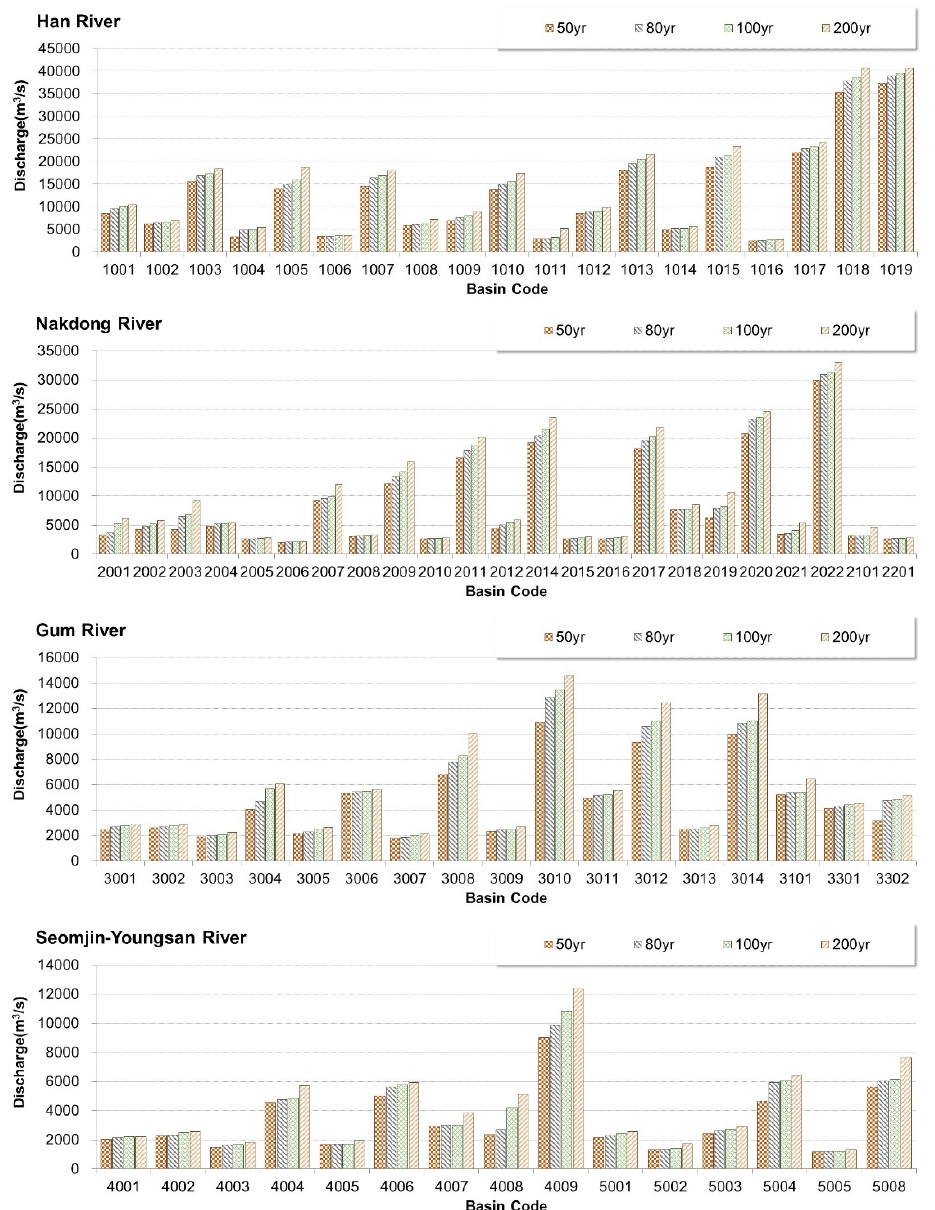
Figure 3. n-year floods according to the RCP 4.5 (CMCC-CM, Total Period).